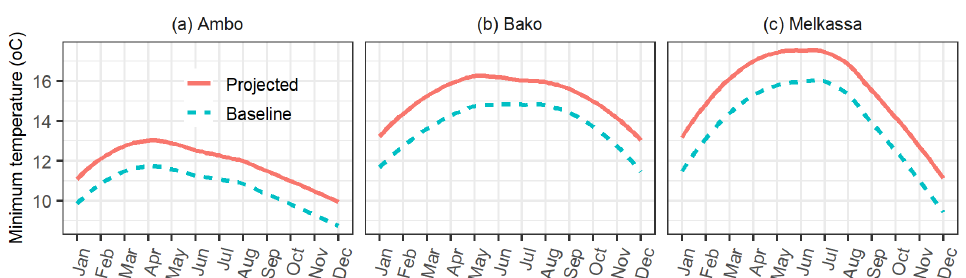
Figure 3. Multimodel ensemble average monthly minimum air temperature projected for 2030 compared to that observed (1995–2017) period for ( a ) Ambo (high altitude), ( b ) Bako (mid-altitude), and ( c ) Melkassa (low altitude).